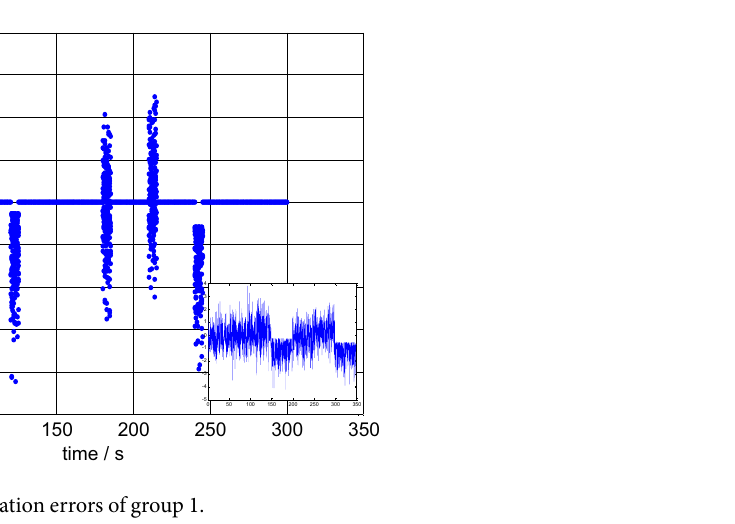
Figure 5. The static elevation errors of group